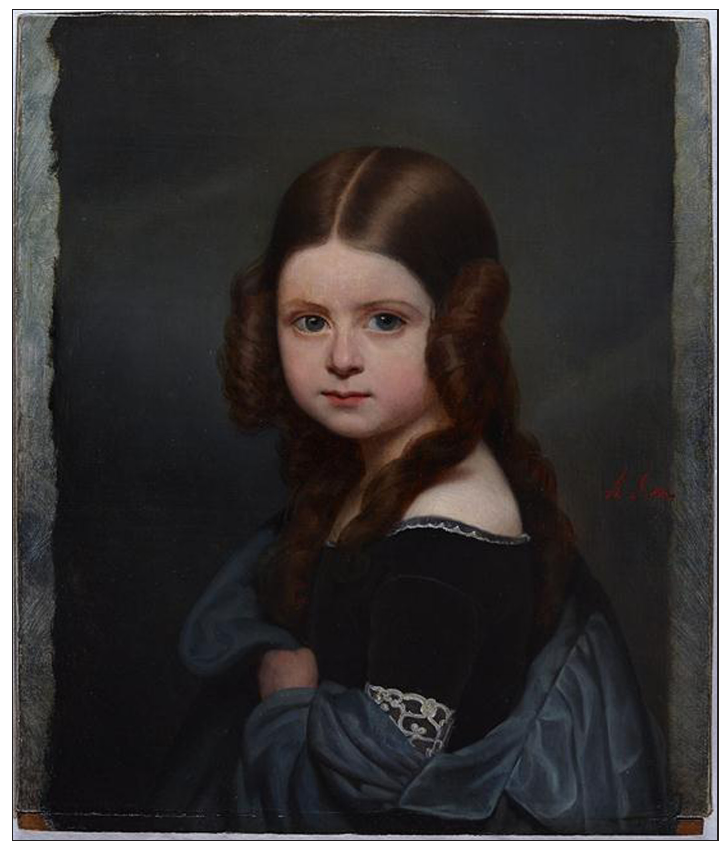
Fig. 8 : Henry Scheffer, Petite fille au manteau bleu , 1844, oil on canvas, 49 × 43.5 cm, Rennes, Musée des Beaux-Arts, INV